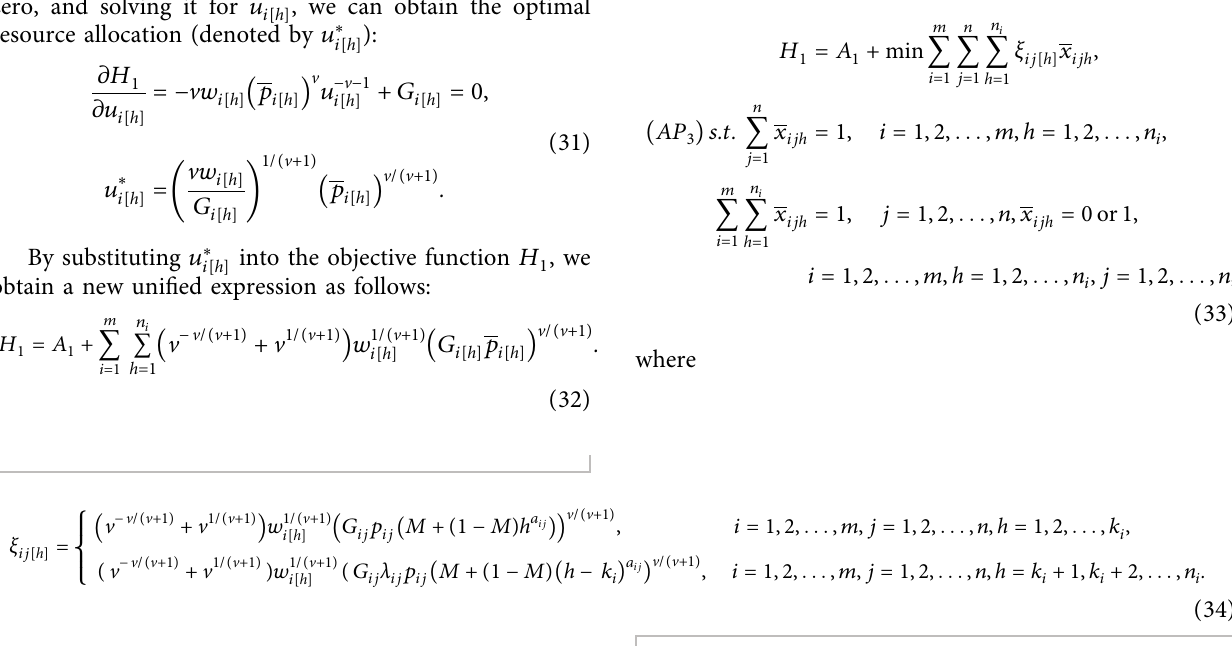
A LGORITHM 3: Algorithm to solve the problem of minimizing the sum of total completion times and total absolute deviation of job completion times with convex resource